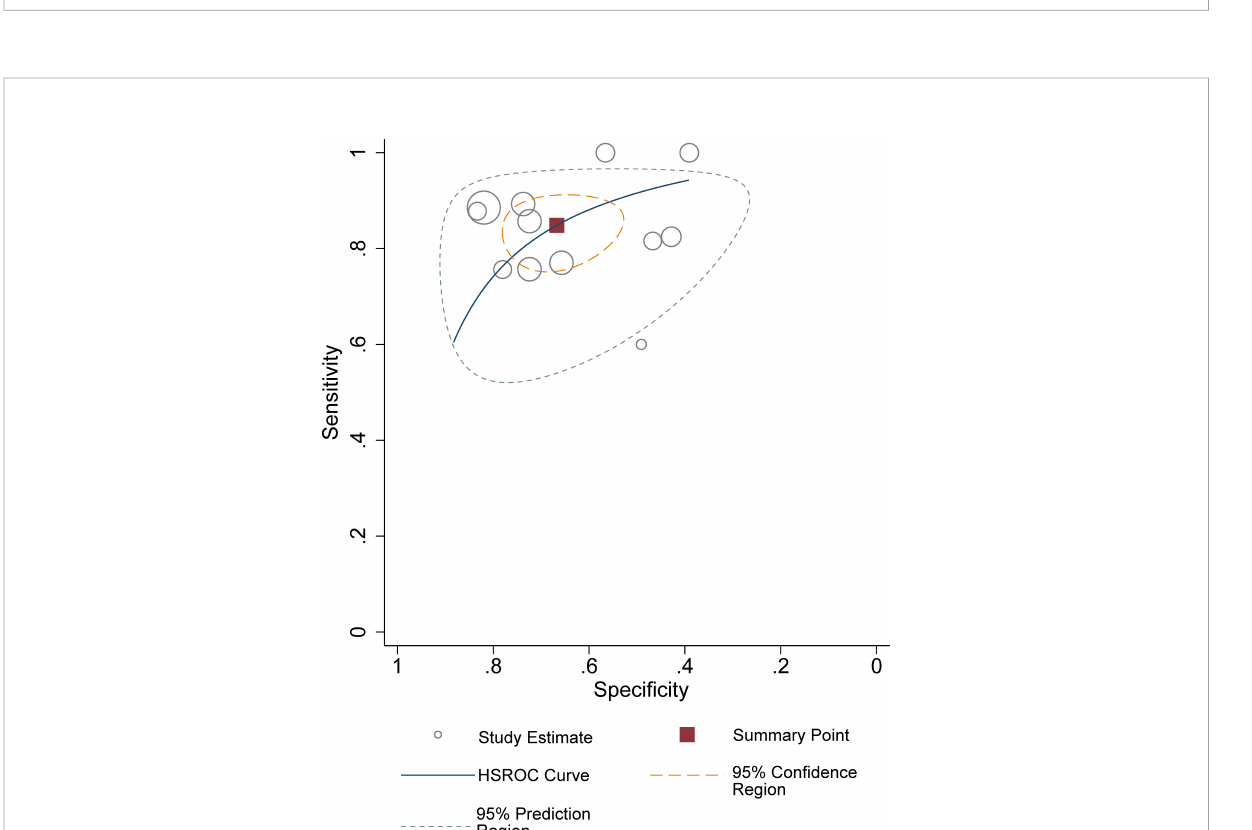
FIGURE 4 The Deeks ’ funnel plot.